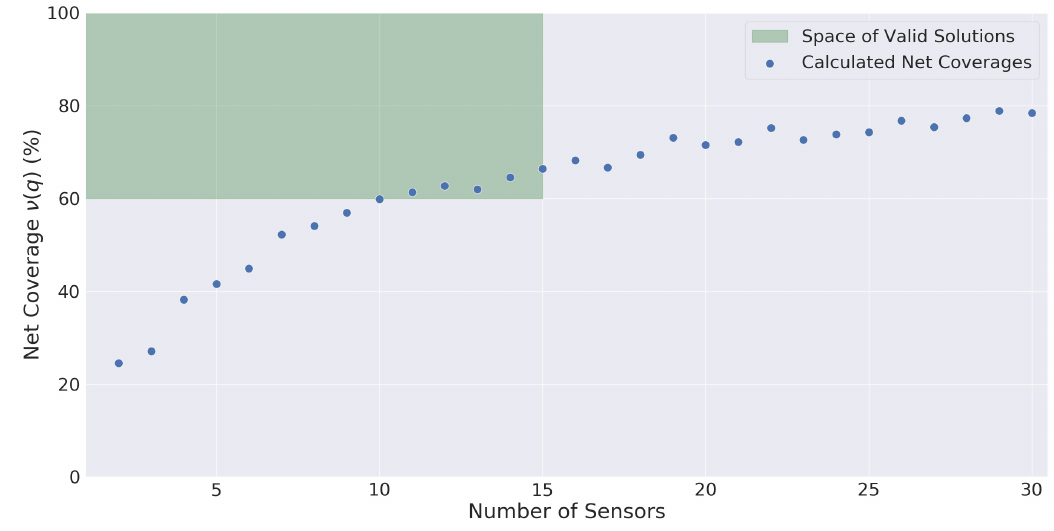
Figure 4. Calculated net coverages and space of solutions fulfilling both objectives (C-Town model).